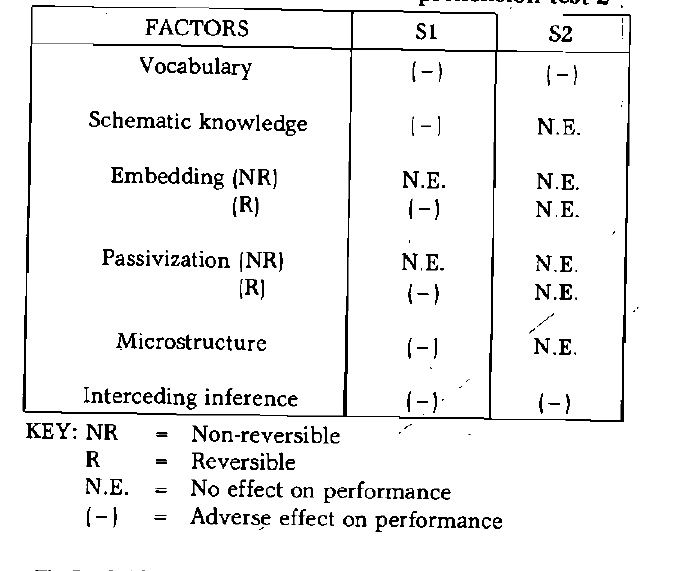
Table 3: Results of inferential comprehension test 2